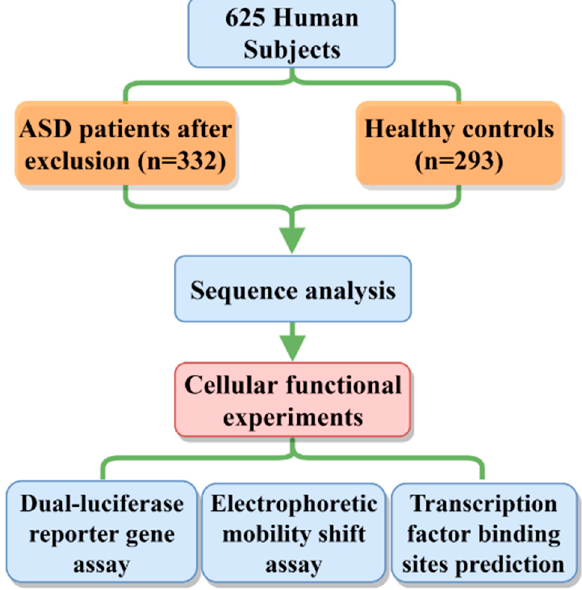
Figure 1. Study flow chart and experimental procedures. A total of 625 subjects participated in the study. Sequence analysis, cell function experiments, electrophoretic mobility shift analysis, and bioinformatics analysis were performed.